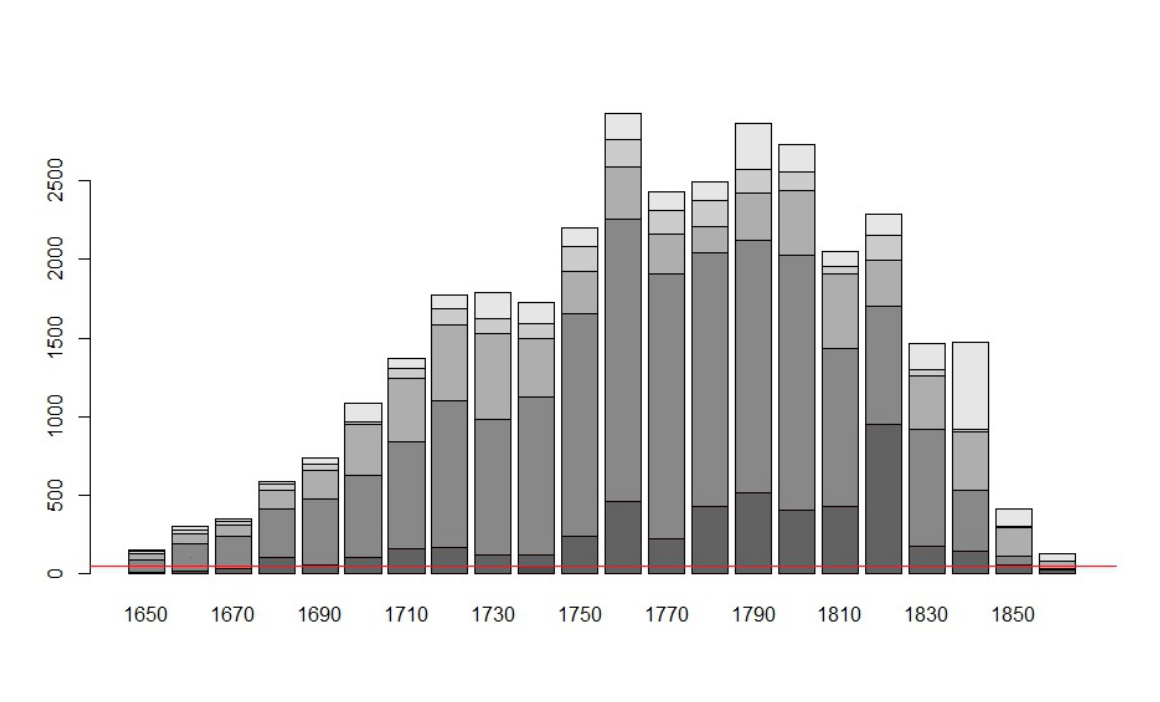
Figure 3. Total known voyages by decade.